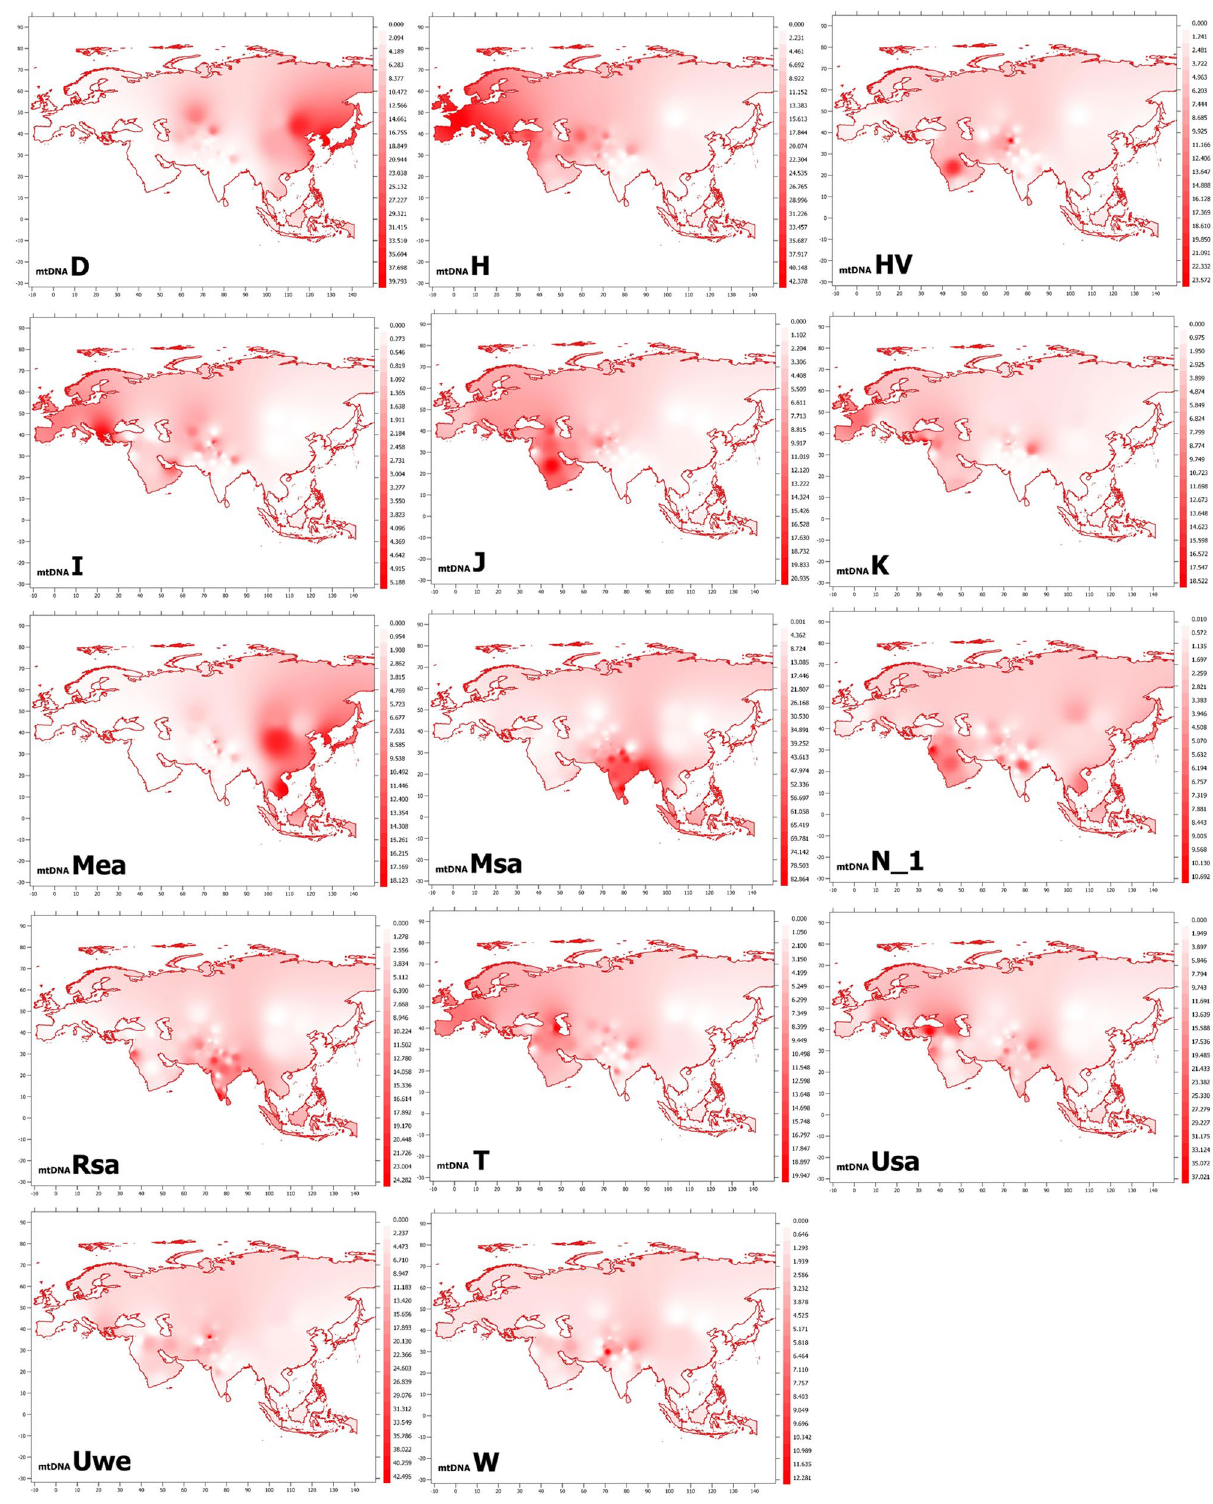
Figure 1. Geospatial map of mtDNA haplogroup frequencies in KPP ethnic groups and comparative populations. See the Methods section for a description of the mapping process, and Table S3 for the data on which the projection is based. With respect to the abbreviations in the different panels in the figure, “M EA ” indicates mtDNAs belonging to East Asian haplogroups deriving from macrohaplogroup M (C, D, G, M7-M9, Z), while “M SA ” denotes those belonging to South Asian haplogroups derived from M (M2-M10, M12, M18, etc.). Similarly, “R SA ” indicates mtDNAs derived from R haplogroups arising in South Asia (e.g., R2, R5, R6, R7, R9, R30, R31), “U WE ” denotes mtDNAs from U haplogroups common to West Eurasian populations (U2e, U3-U5, U7, U8), and “U SA ” mtDNAs from U haplogroups identified in South Asian populations (U*, U1,